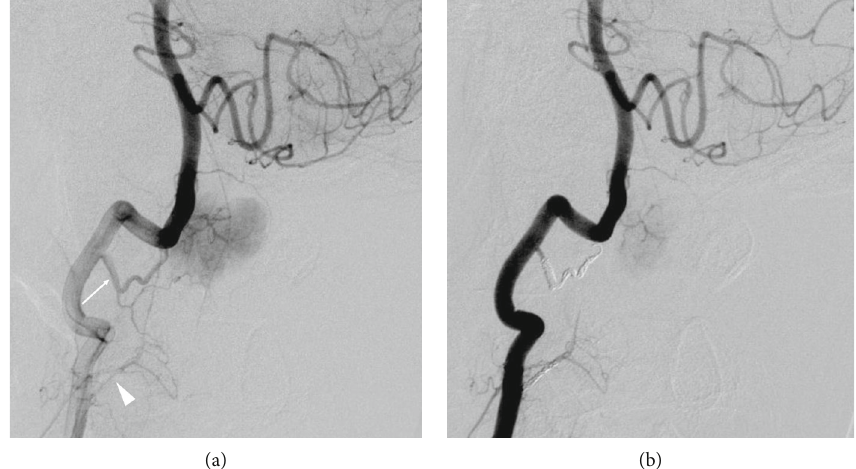
Figure 2: (a) Right vertebral angiogram demonstrating tumor staining, supplied by the right C2 (arrow) and C3 (arrowhead) segmental arteries. (b) A right vertebral angiogram after embolization using a coil showing slight tumor